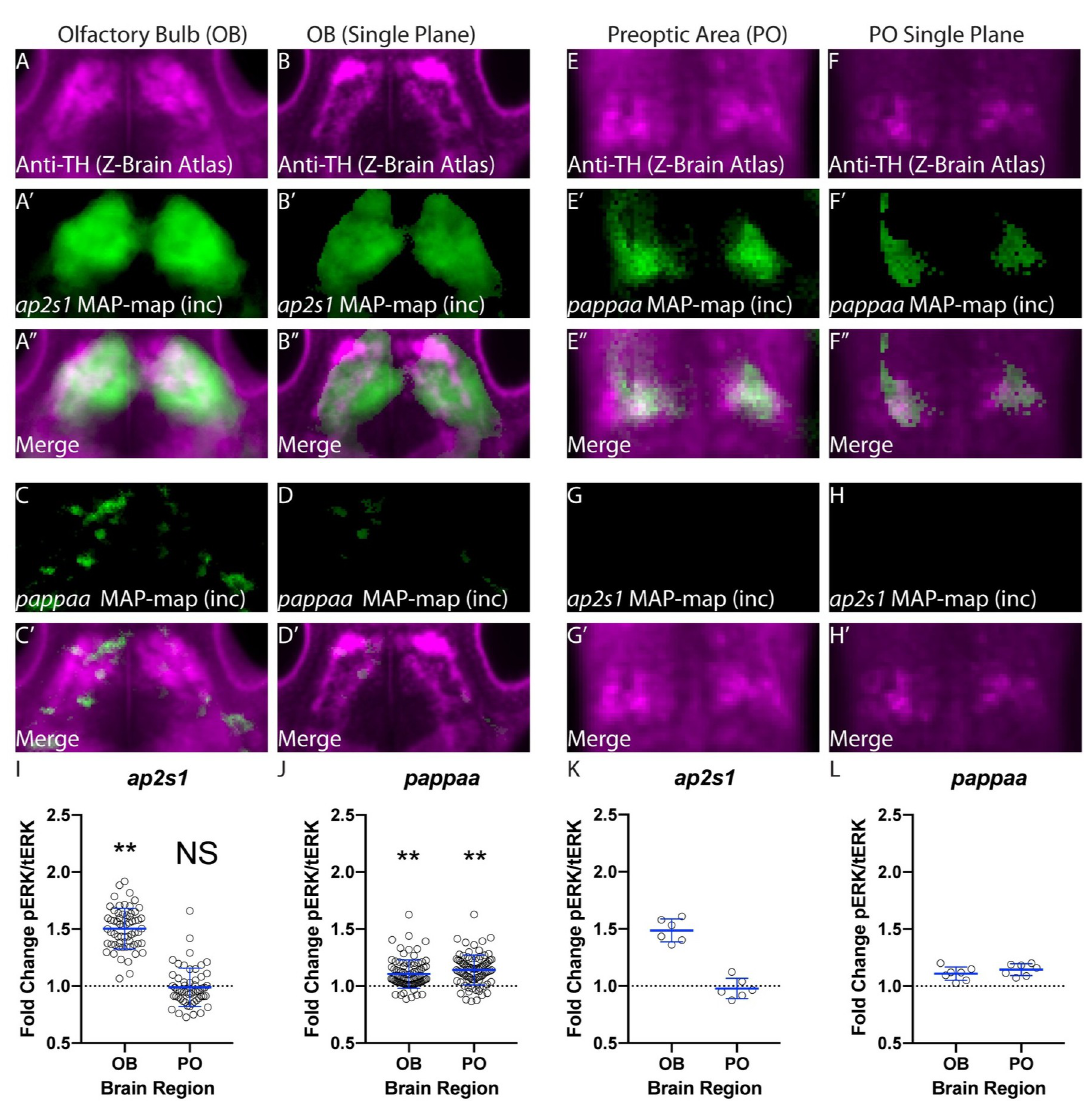
Fig 7. Th-immunoreactive neurons in the olfactory bulb and preoptic area show increased activity in ap2s1 and pappaa mutants respectively. (A) Summed Z-projection of Th signal within the olfactory bulb obtained from the Z-brain Atlas [31]. (A’) Representative example of a summed projection from a single experiment showing regions of increased activity within the olfactory bulb in ap2s1 mutants relative to their siblings during habituation learning. (A”) A merge of A and A’ showing co-registration of Th-immunoreactive areas and regions of increased activity in ap2s1 mutants relative to siblings during habituation. Areas of increased activity in ap2s1 mutants during habituation learning show strong overlap with Th-immunoreactive olfactory bulb regions. (B) A single z-plane through the olfactory bulb Th-stained area shown in (A). (B’) The same z-plane as in B taken from the stack in A’ showing regions of increased activity within the olfactory bulb in ap2s1 mutants relative to their siblings during habituation learning. (B”) Merge of (B) and (B’) . The x-y overlap indicated in (A-A”) occurs within the same z-plane. (C-C’) same as (A’-A”) but for pappaa mutants. (D-D’) same as (B’-B) but for pappaa mutants. (E) Summed Z-projection of anti-Th signal within a sub-region of the preoptic area obtained from the Z-brain Atlas [31]. (E’) Representative example of a summed projection from a single experiment showing regions of increased activity within the preoptic area in pappaa mutants relative to their siblings during habituation learning. (E”) A merge of E and E’ showing co-registration of Th-stained areas and regions of increased activity in pappaa mutants relative to siblings during habituation. Areas of increased activity in pappaa mutants during habituation learning show strong overlap with Th-positive preoptic regions. (F) A single z-plane through the preoptic area shown in (E) . (F’) The same z-plane as in (F) taken from the stack in E’ showing regions of increased activity within the preoptic area in pappaa mutants relative to their siblings during habituation learning. (F”) Merge of (F) and (F’) . The x-y overlap indicated in (E’-E”) occurs within the same z-plane. (G-G’) same as (E’-E”) but for ap2s1 mutants. (H-H’) same as (F’-F”) but for ap2s1 mutants. ap2s1 mutants do not show upregulation within neurons of the preoptic area that stain positive for Th. (I) Quantification of the fold-change in pERK/tERK in ap2s1 mutants relative to their siblings within ROIs encompassing either the olfactory bulb dopaminergic area on each side or ROIs encompassing the preoptic dopamine clusters on each side. Each point represents the region-specific